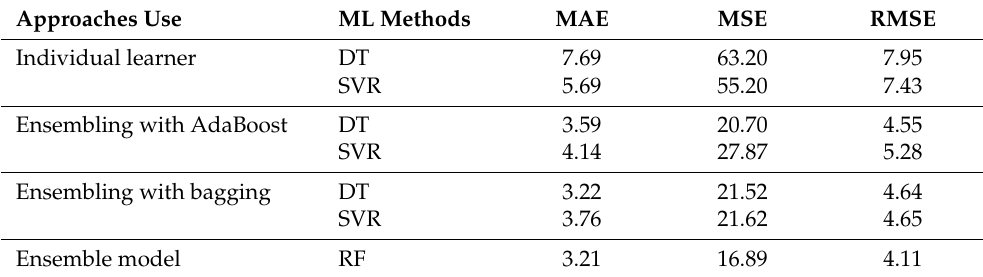
Table 5. Statistical analysis.